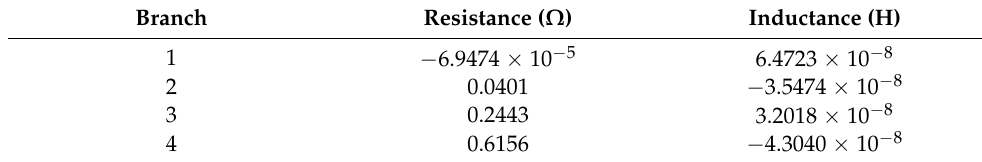
Table 2. Parameters of four branches.